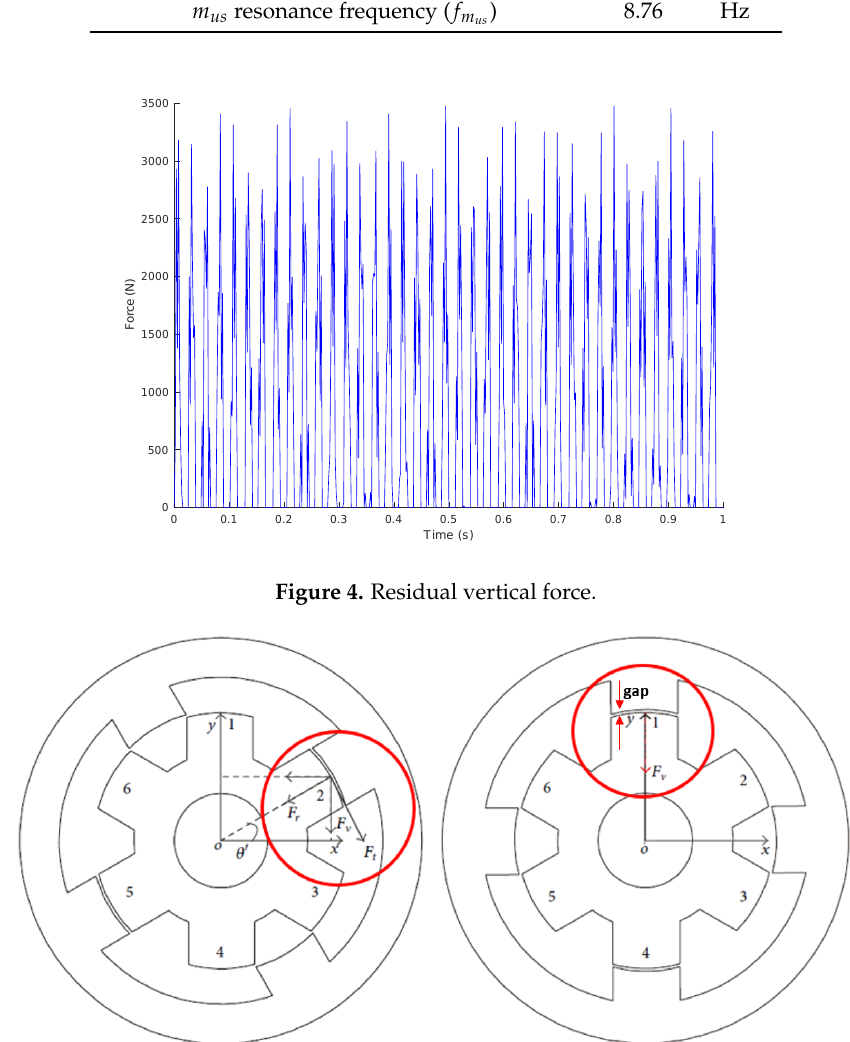
Figure 5. Switched reluctance motor (SRM) residual vertical force diagram, adapted from Reference